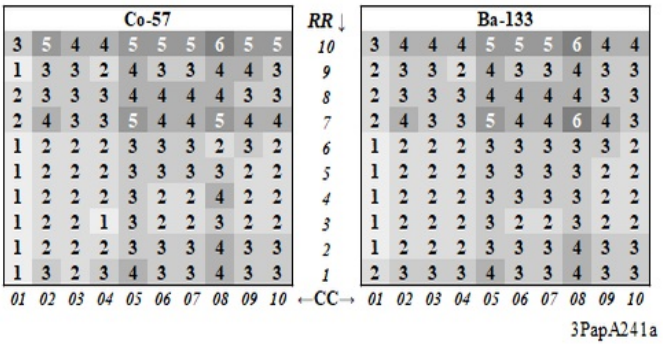
Figure 8. Array maps representing the crystal pixel’s Fsym values by clusters from Co-57 ( left ) and Ba-133 ( right ) data. Bin-sizes values of 4.0-, and 2.8-mm were used, respectively. The locations of pixels in the array were described by the RRCC codes.